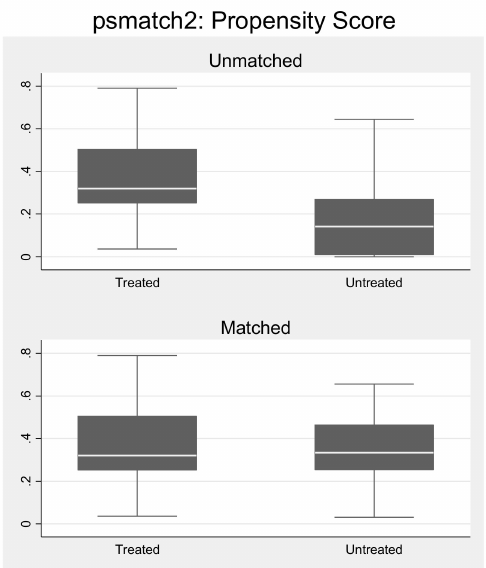
Figure A1. Box plot before and after